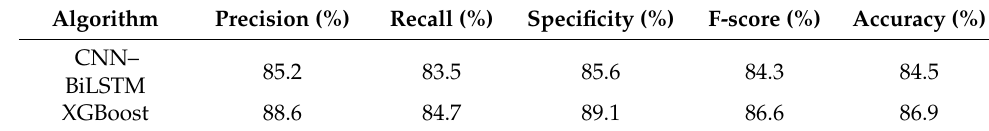
Table 4. Test results using LIWC-based features.